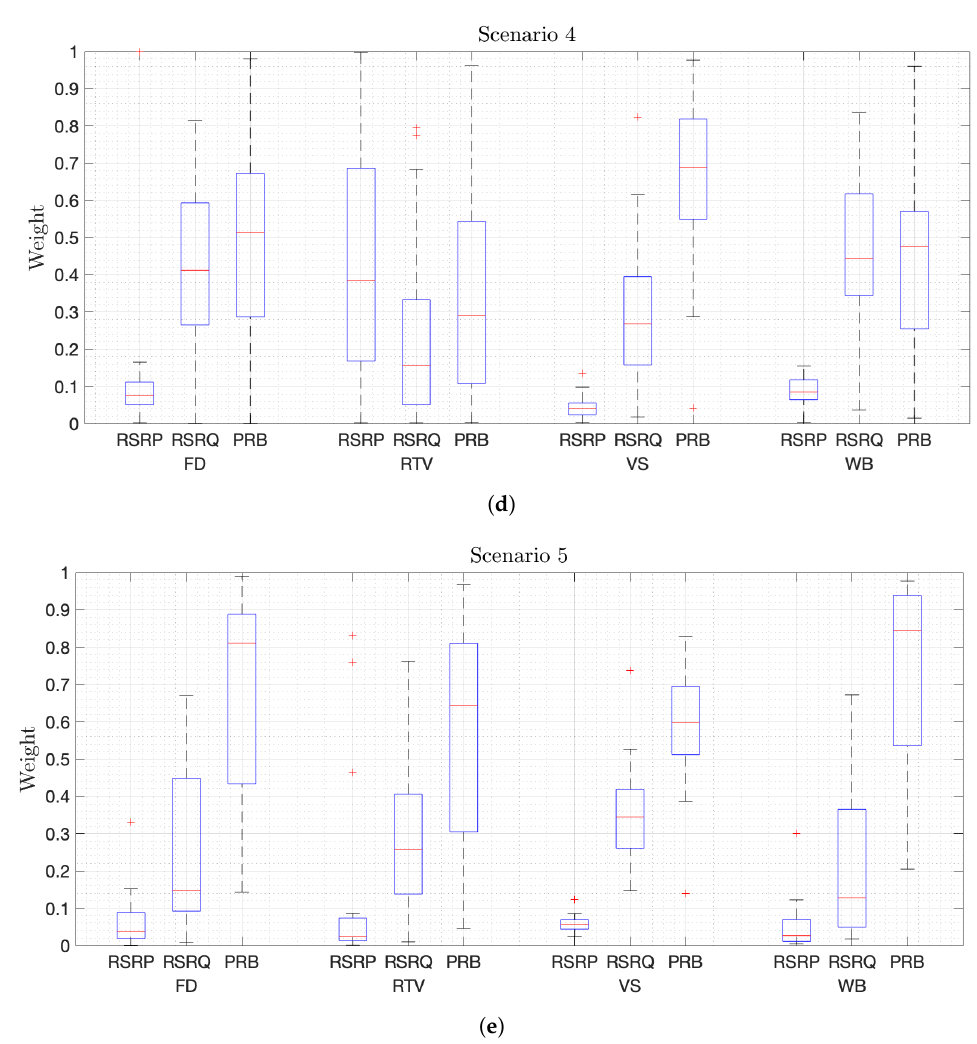
Figure 5. Weight of each metric of the estimation model for each service and scenario. ( a ) Weights in Scenario 1. ( b ) Weights in Scenario 2. ( c ) Weights in Scenario 3. ( d ) Weights in Scenario 4. ( e ) Weights in Scenario